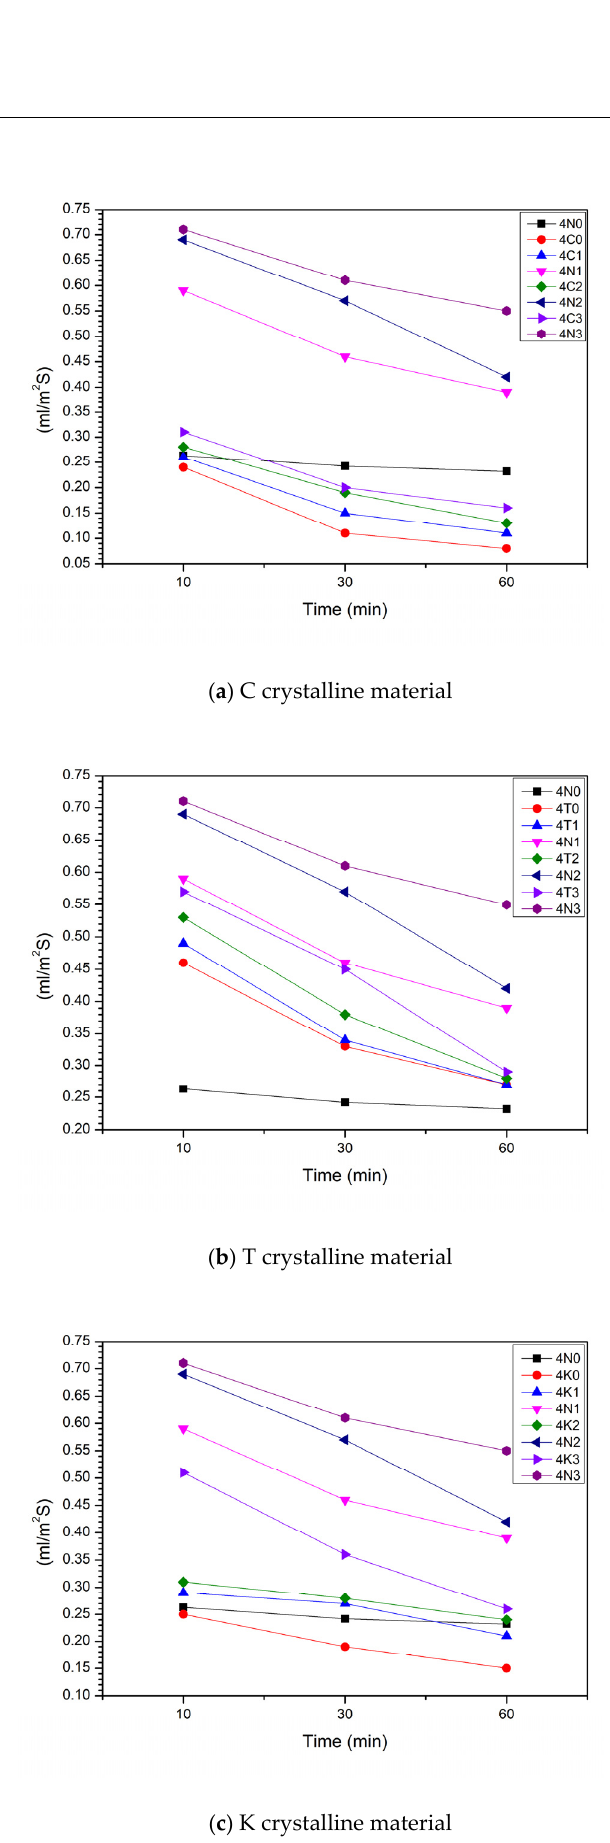
Figure 10. Initial surface water absorption of cement mortar after 56 days when W/C = 0.4.